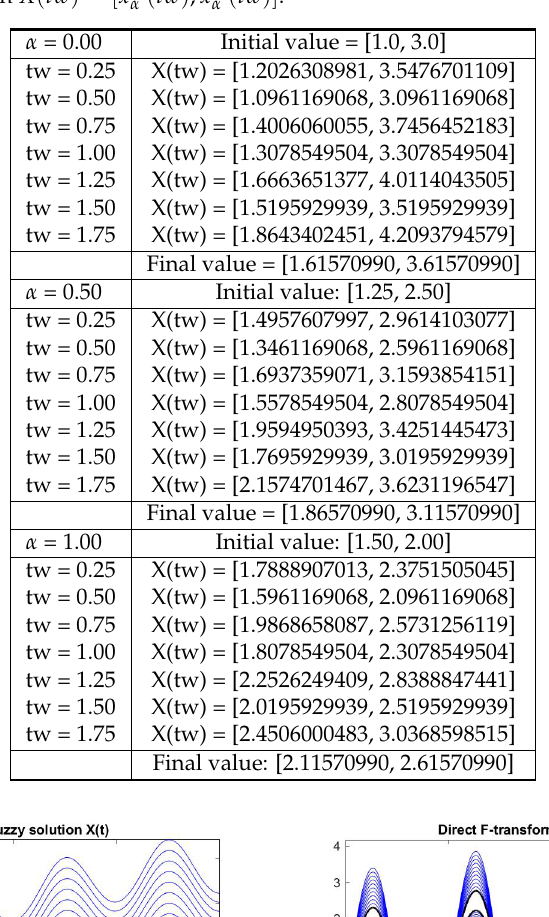
Table 1. (Interval-valued problem IDE1-a): For three values of α ∈ { 0,0.5,1 } , the seven switching points tw corresponding to Meth=1 are given in the first column; the second column contains the interval-valued solution X ( tw ) = [ x − α ( tw ) , x + α ( tw )] .